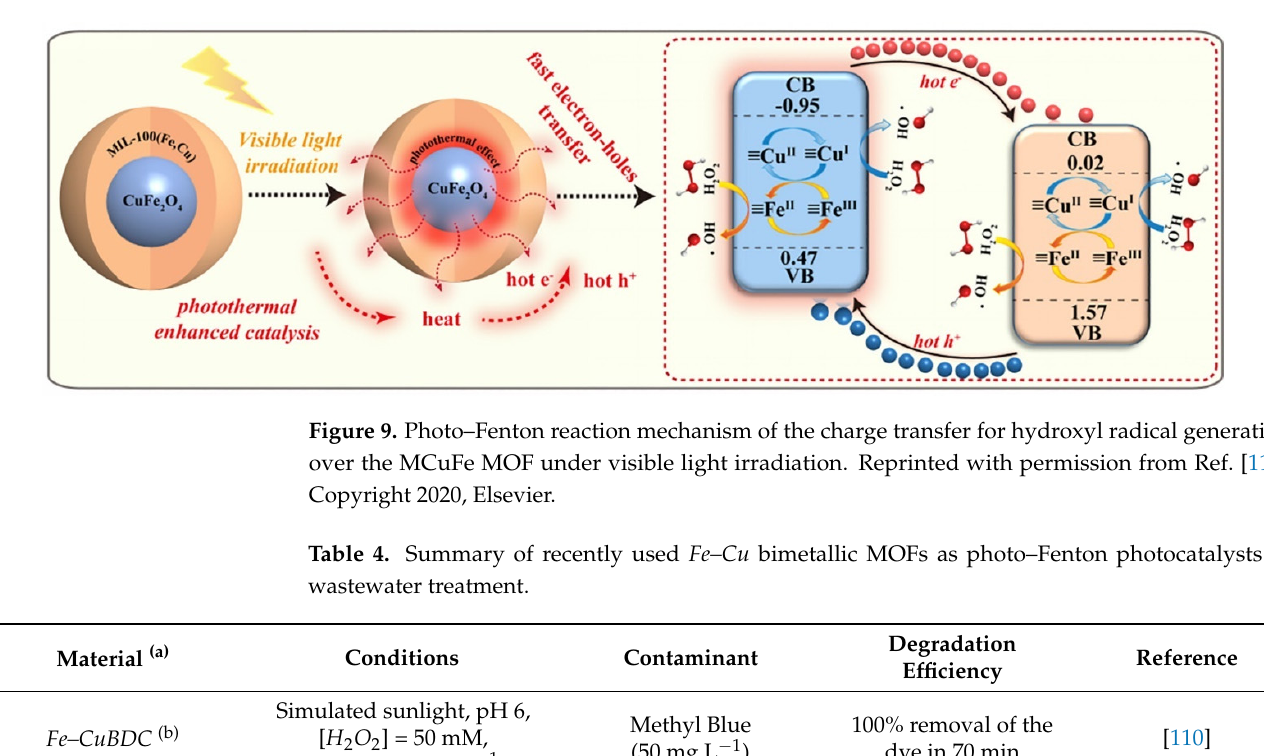
Figure 8. Schematic diagram of the synthesis process of MCuFe MOF. Reprinted with permission from Ref. [111]. Copyright 2020, Elsevier.